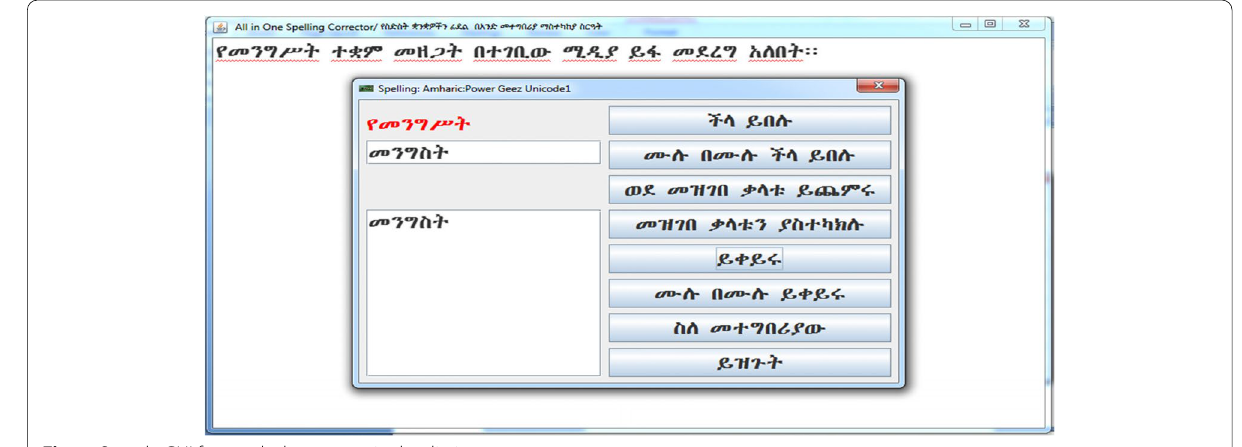
Fig. 5 Sample GUI for words that are not in the dictionary